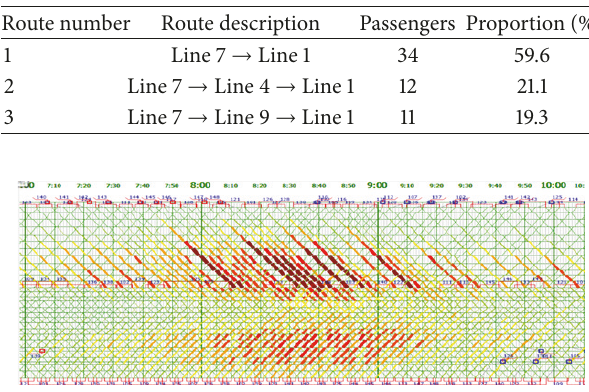
Figure 8: Example of factual train diagrams with passenger flows on sections and load factors of